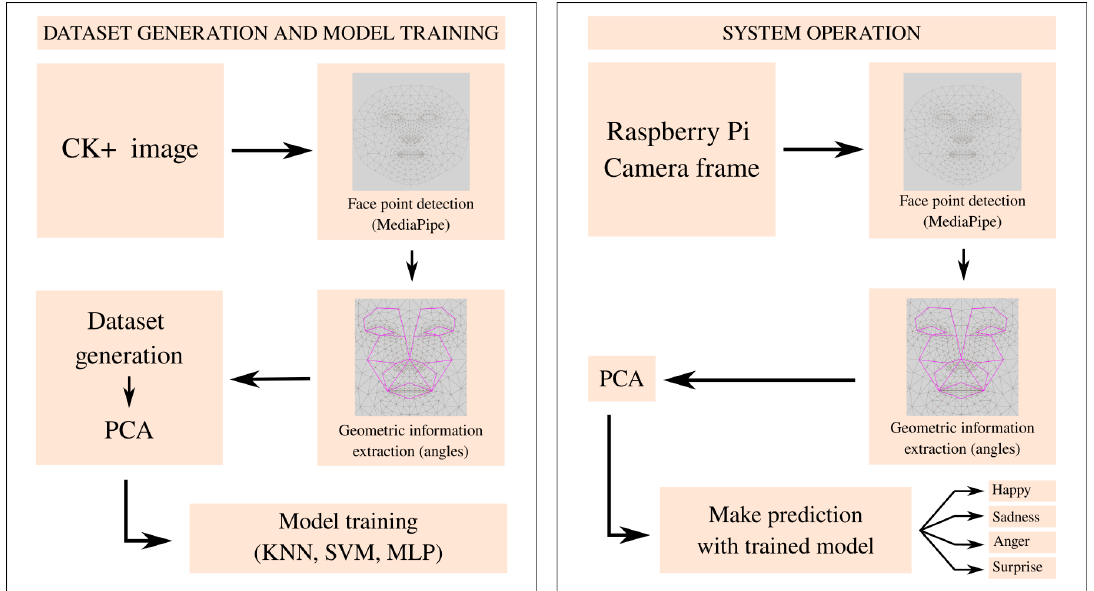
Figure 1. Schema of the emotion detection system